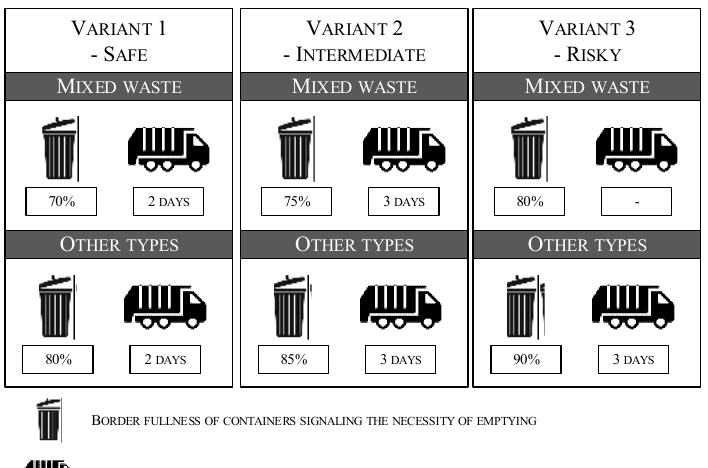
Figure 6. New emptying system—load levels.